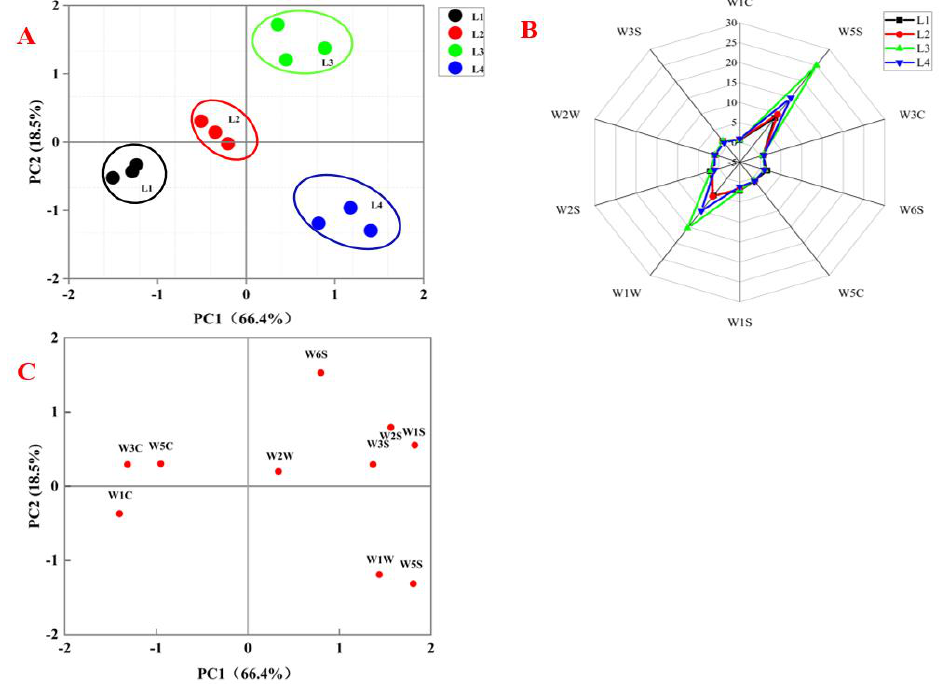
Figure 7. E-nose analysis. ( A ) PCA plot of the samples at different processing stages. ( B ) Radar graph of the samples at different processing stages. ( C ) PCA loading plot of the samples at different processing stages.